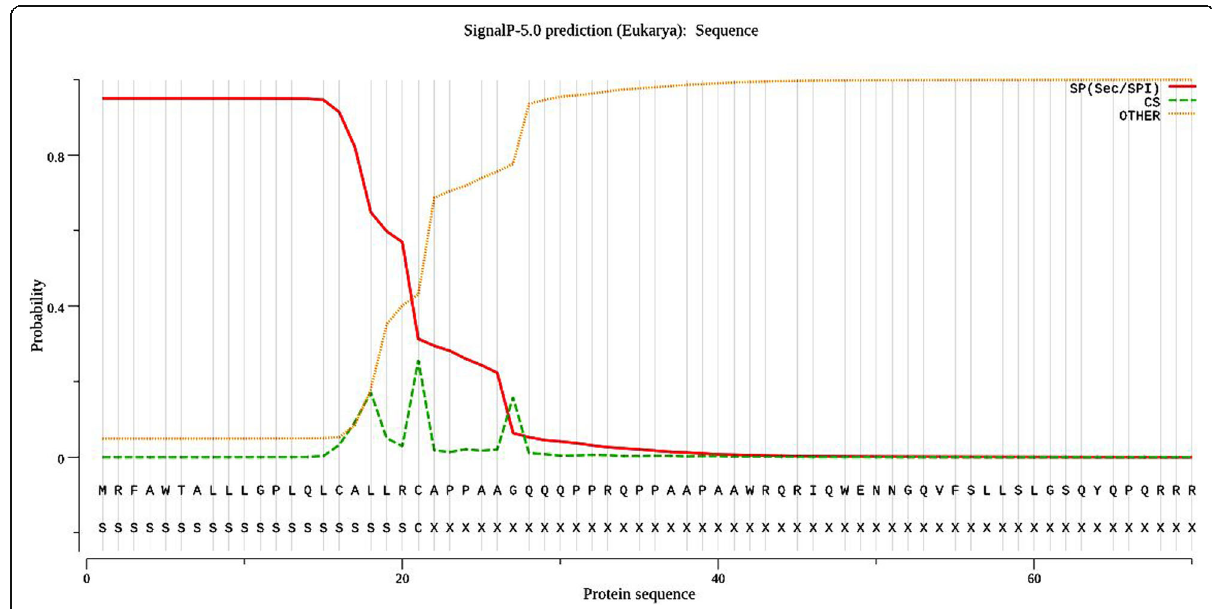
Fig. 8 SignalP-5.0 prediction. Signal peptide likelihood was around 0.9505. Predicted location of peptide cleavage site was between position 21 and 22